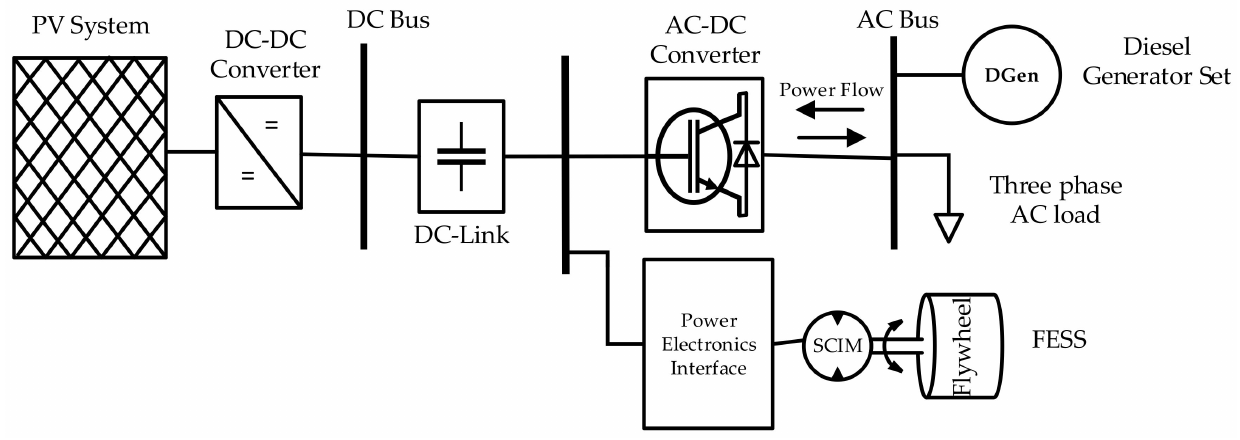
Figure 3. Schematic design of proposed